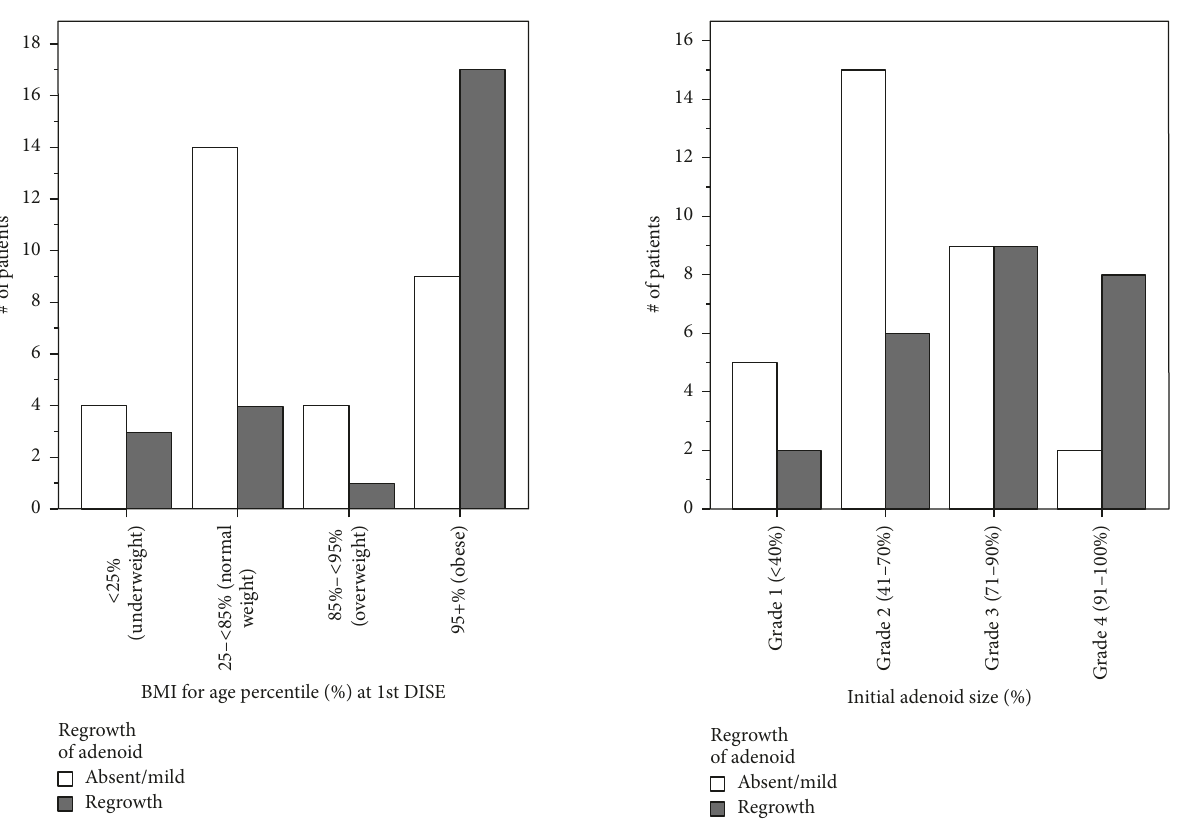
Figure 4: Relationship between initial adenoid size with subsequent adenoid regrowth ( 𝑃 < 0.01